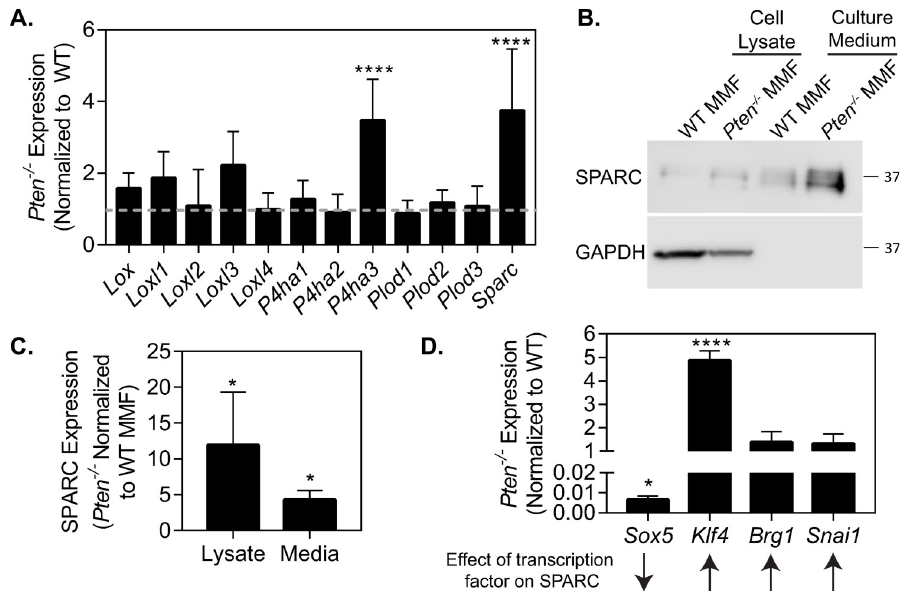
Fig 4. Pten loss upregulates SPARC expression. (A) mRNA expression of collagen-processing proteins. n = 5+SD. (B) Western blotting for SPARC expression, with GAPDH as a loading control. (C) Quantification of SPARC expression in cell lysate and culture medium, normalized to WT. n = 3+SD. (D) mRNA expression of transcription factors known to affect SPARC. n = 3+SD. � p < 0.05, ���� p <